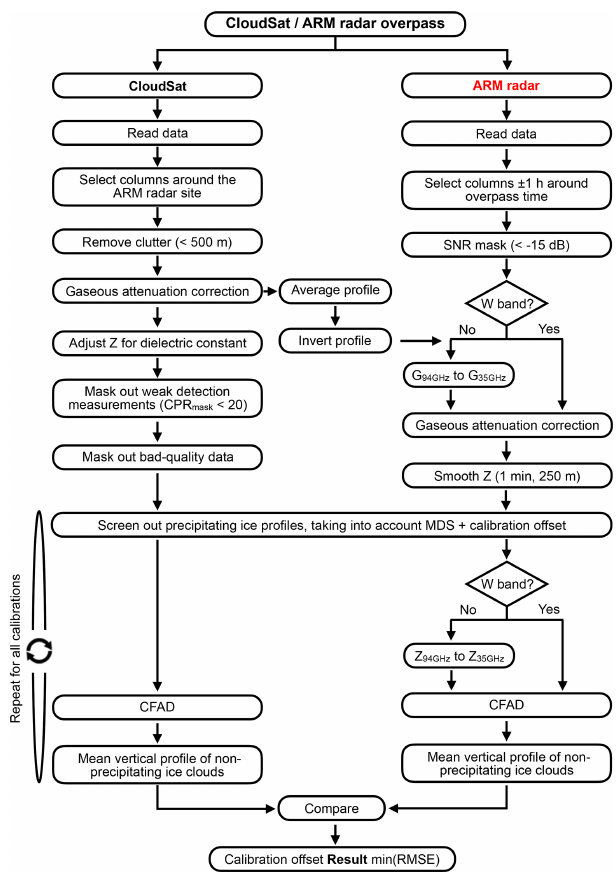
Figure 3. Algorithm flowchart of the calibration of the ARM cloud radars using CloudSat